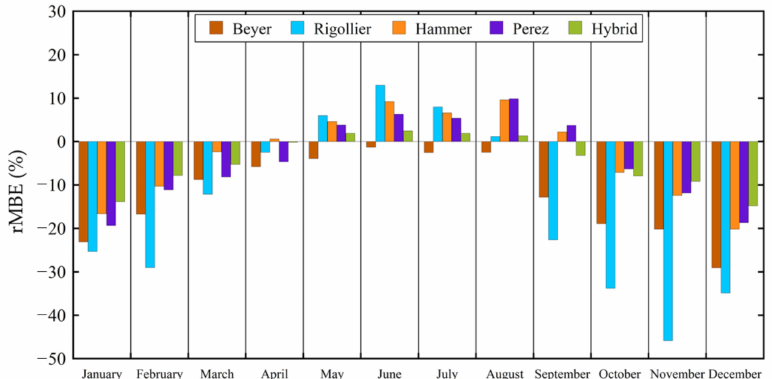
Figure 8. Comparison of monthly accuracy based on rRMSE (%).